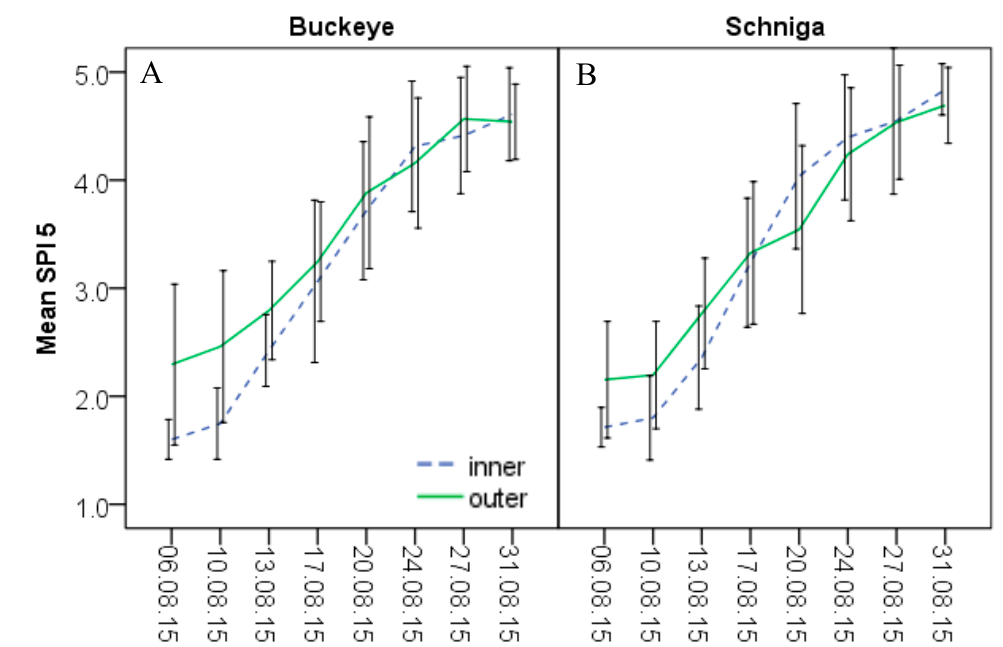
Figure 2. Changes (mean and standard deviation) of starch pattern index (SPI 5) in the inner and outer canopy fruit during maturation (6 August to 31 August) in season 2015 for ( A ) cv. ‘Gala Buckeye’ and ( B ) cv. ‘Gala Schniga’.